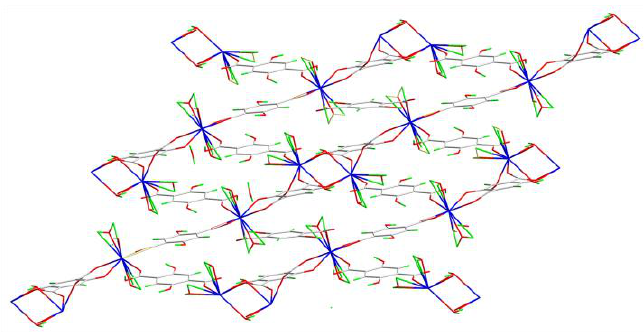
Figure 2. The coordination polyhedra of the holmium atoms.